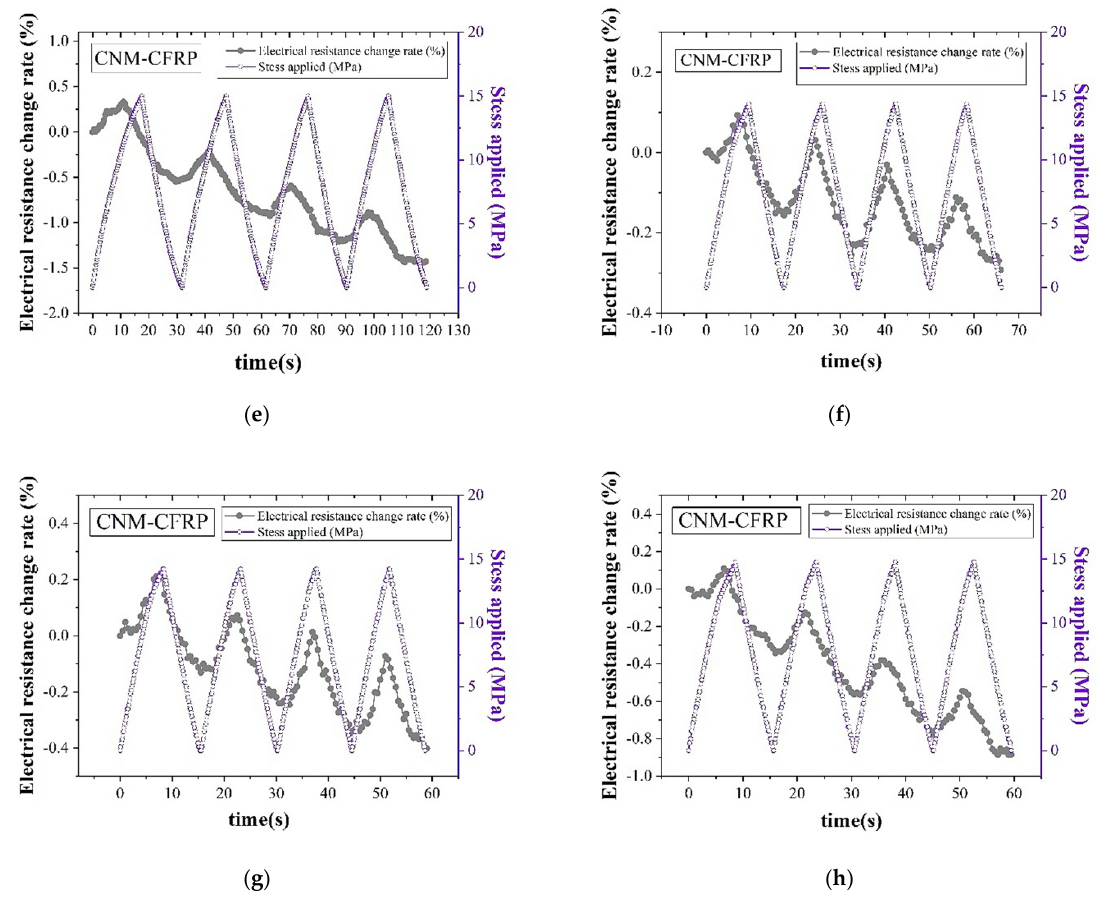
Figure 8. The electrical resistance change rate and applied stress of the ( a ) pure epoxy CFRP, ( b ) CNT-only CFRP 1.5%, ( c ) CNT–graphene CFRP 1.5%, ( d ) CNT–graphene CFRP 3%, ( e ) CNT–CNF CFRP 1.5%, ( f ) CNT–CNF CFRP 3%, ( g ) CNT–GNP CFRP 1.5%, and ( h ) CNT–GNP CFRP 3% composites obtained through the cyclic tensile loading tests.